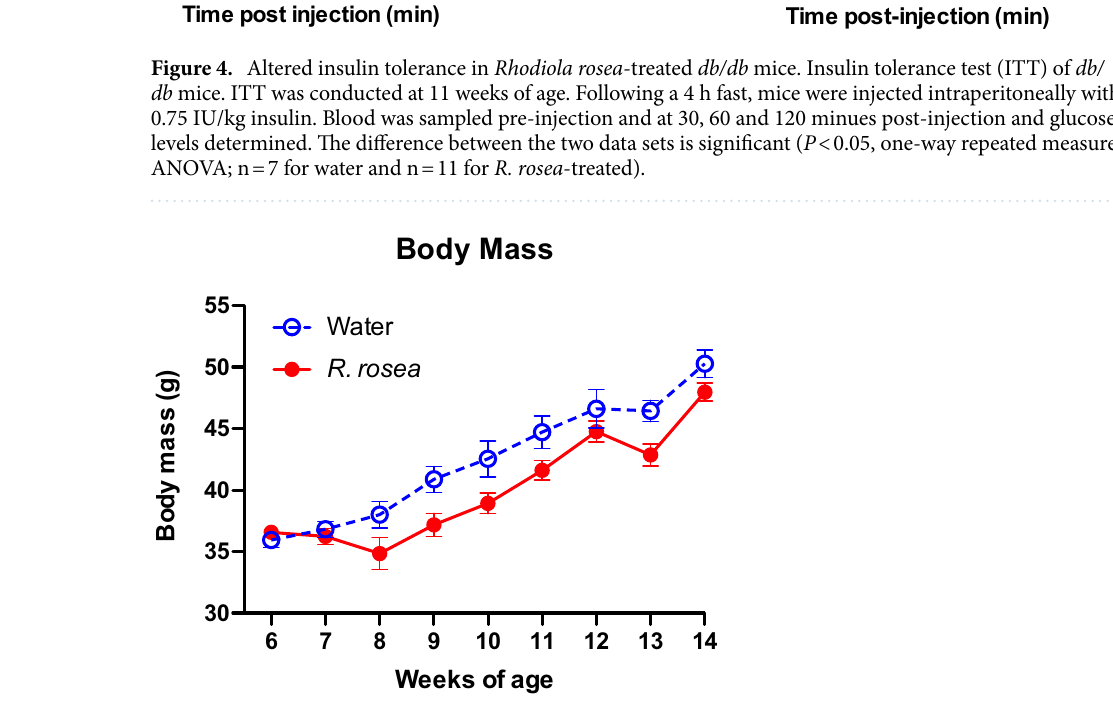
Figure 5. Effect of Rhodiola rosea treatment on body weight of db/db mice. Mice in each cohort (n = 8 water- treated, n = 11 R. rosea -treated) were weighed weekly starting just before initiation of treatment (week 6). None of the paired differences in weight were significant (one-way repeated measures